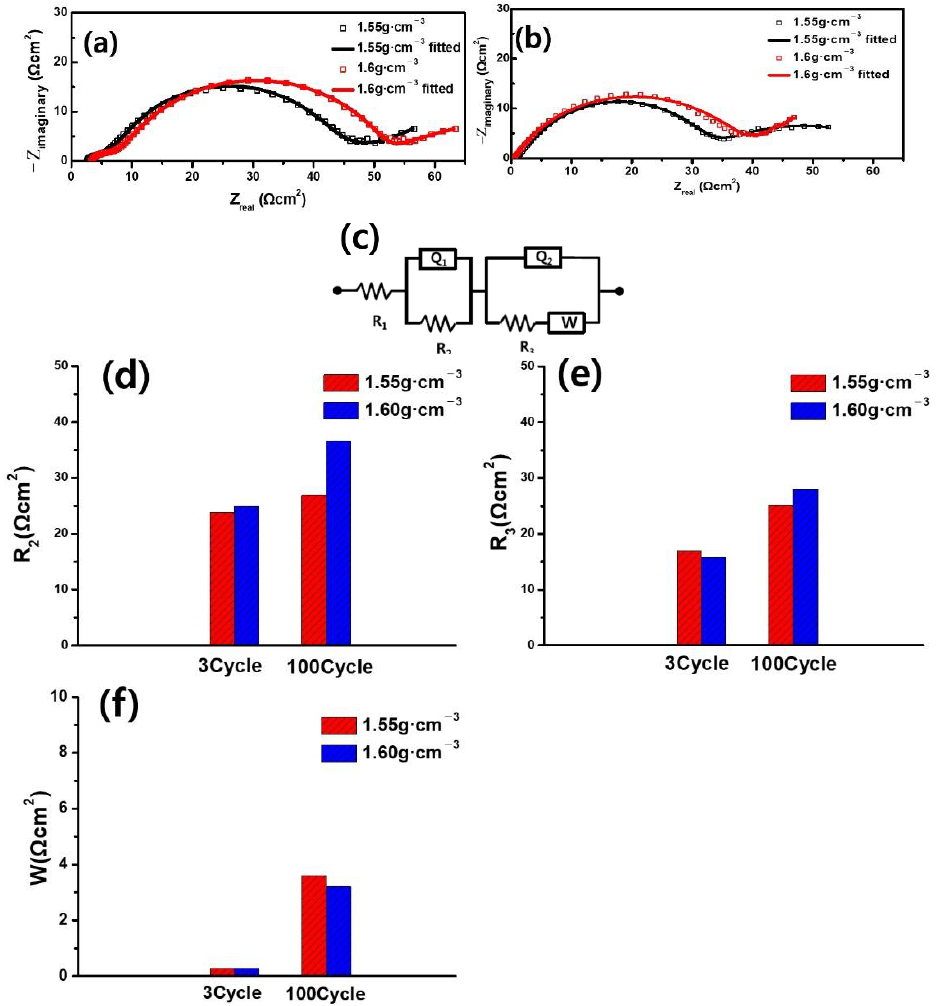
Figure 5. Nyquist plots of AG electrode ( a ) after 3 cycles and ( b ) after 100 cycles at different electrode densities; ( c ) equivalent circuit used for the fitting; and comparison of ( d ) film resistance (R2), ( e ) charge-transfer resistance (R3), and ( f ) Warburg resistance (W) of AG electrodes after 3 and 100 cycles. The Nyquist plots show a depressed semicircle, followed by a short, sloping